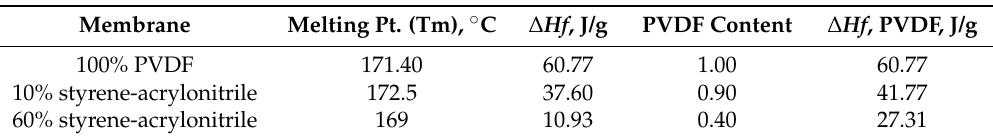
Table 3. Melting point (Tm), melting enthalpy ( ∆ H f ) of membranes obtained from a differential scanning calorimeter (DSC).